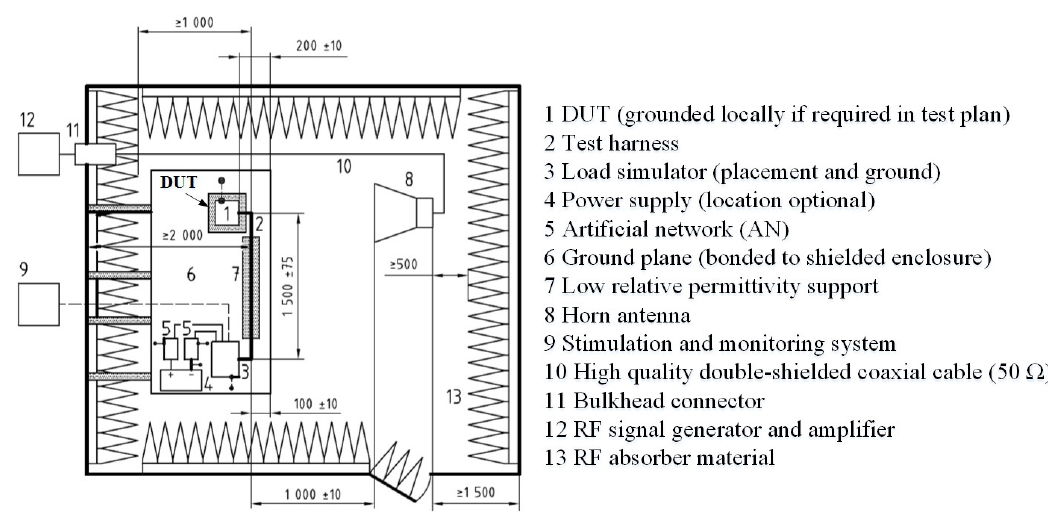
Figure 1. ISO 11452-2 far-field radiated immunity test setup for frequencies above 1 GHz